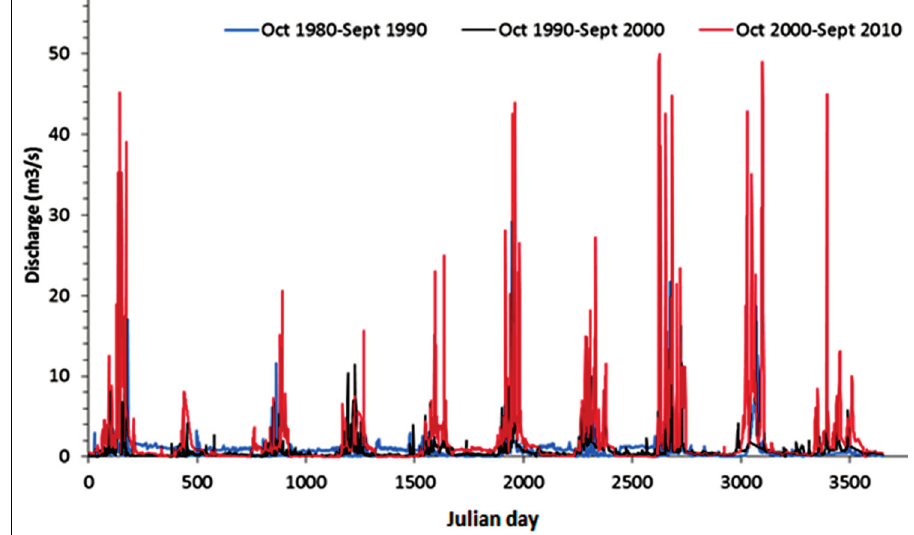
Figure 8. Comparison of streamflow hydrographs in Marimba catchment for the three periods.